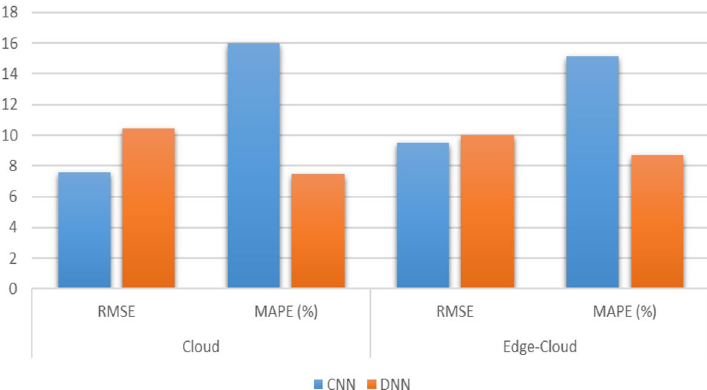
Fig. 15 Results of CNN and DNN models for cloud only and edge-cloud platform in terms of RMSE and MAPE [the smaller values are better than the larger ones]